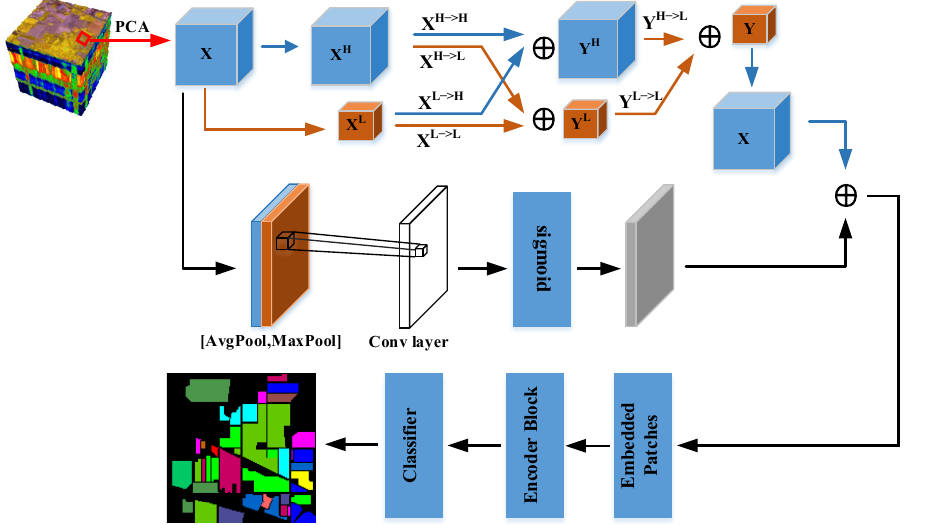
Figure 6. Spatial attention network structure combining 3D Octave convolution and ViT.